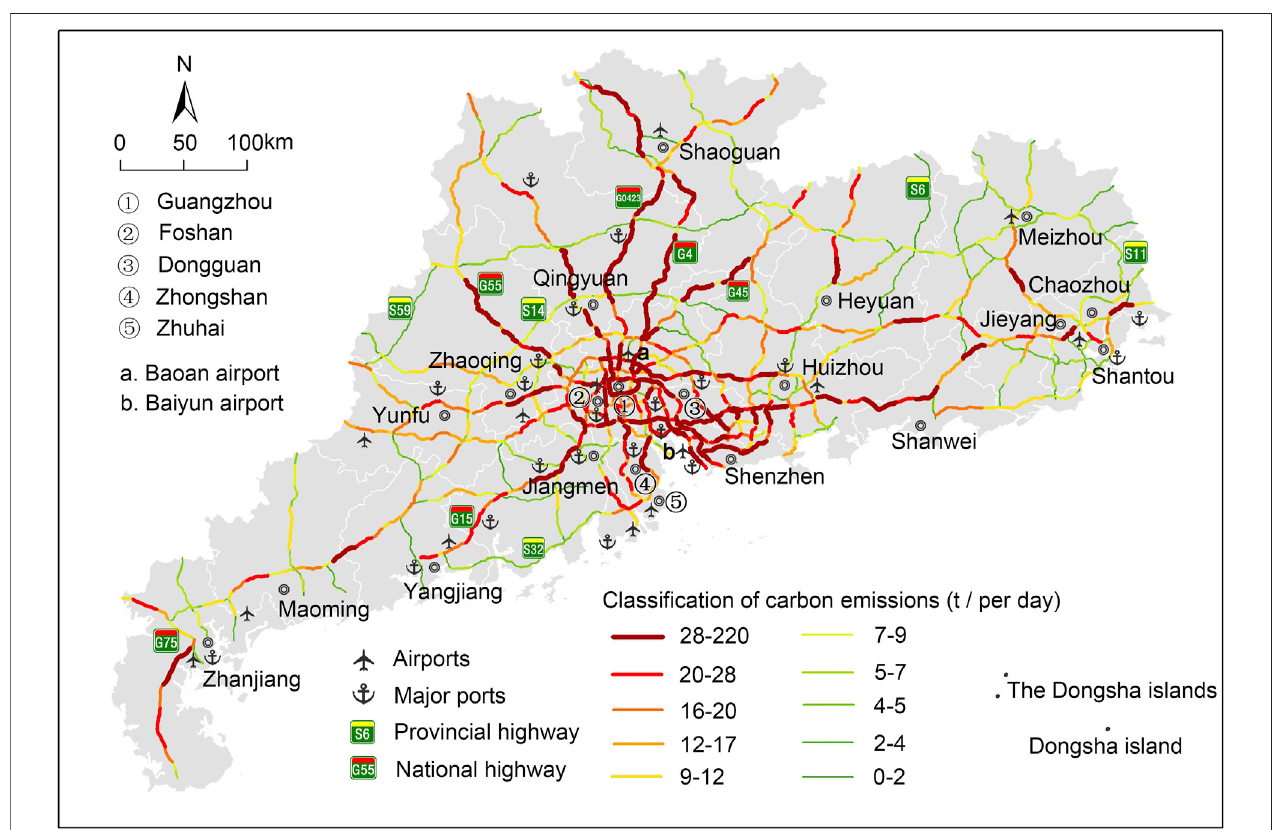
FIGURE 6 | Spatial patterns of carbon emissions for all vehicle types on highways in Guangdong